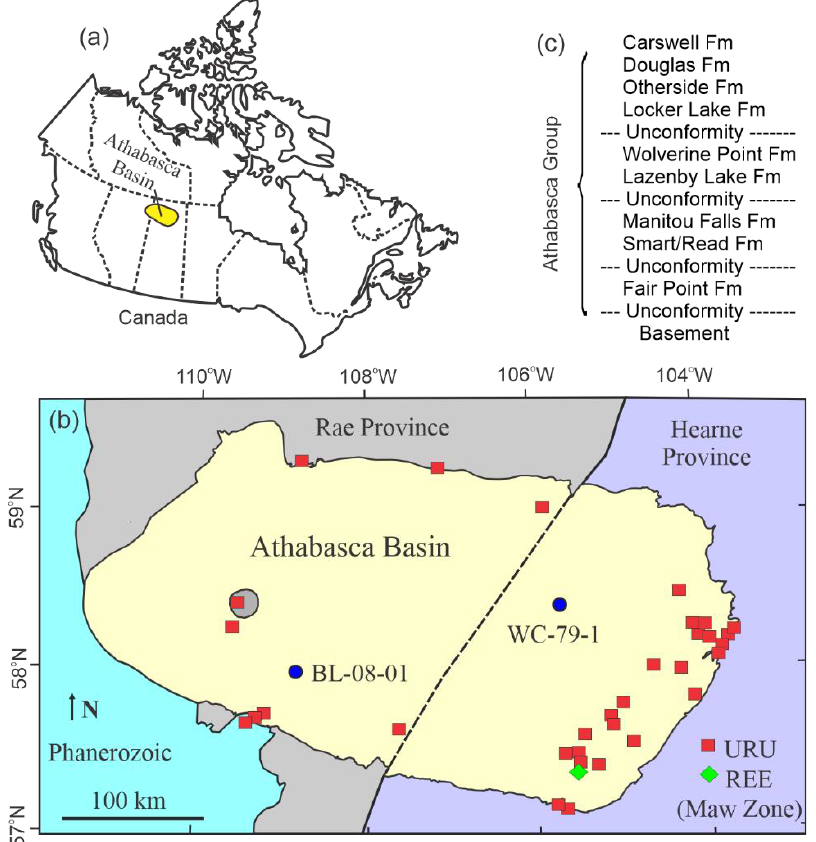
Figure 1. ( a ) A map of Canada indicating the location of the Athabasca Basin; ( b ) a geological map of the Athabasca Basin showing the distribution of unconformity-related uranium (URU) deposits and a hydrothermal REE deposit (Maw Zone). Drill holes from which the samples in this study were collected (WC-79-1 and BL-08-01) are indicated by the circles; ( c ) a simplified stratigraphic column of the Athabasca Basin (modified from [36]).